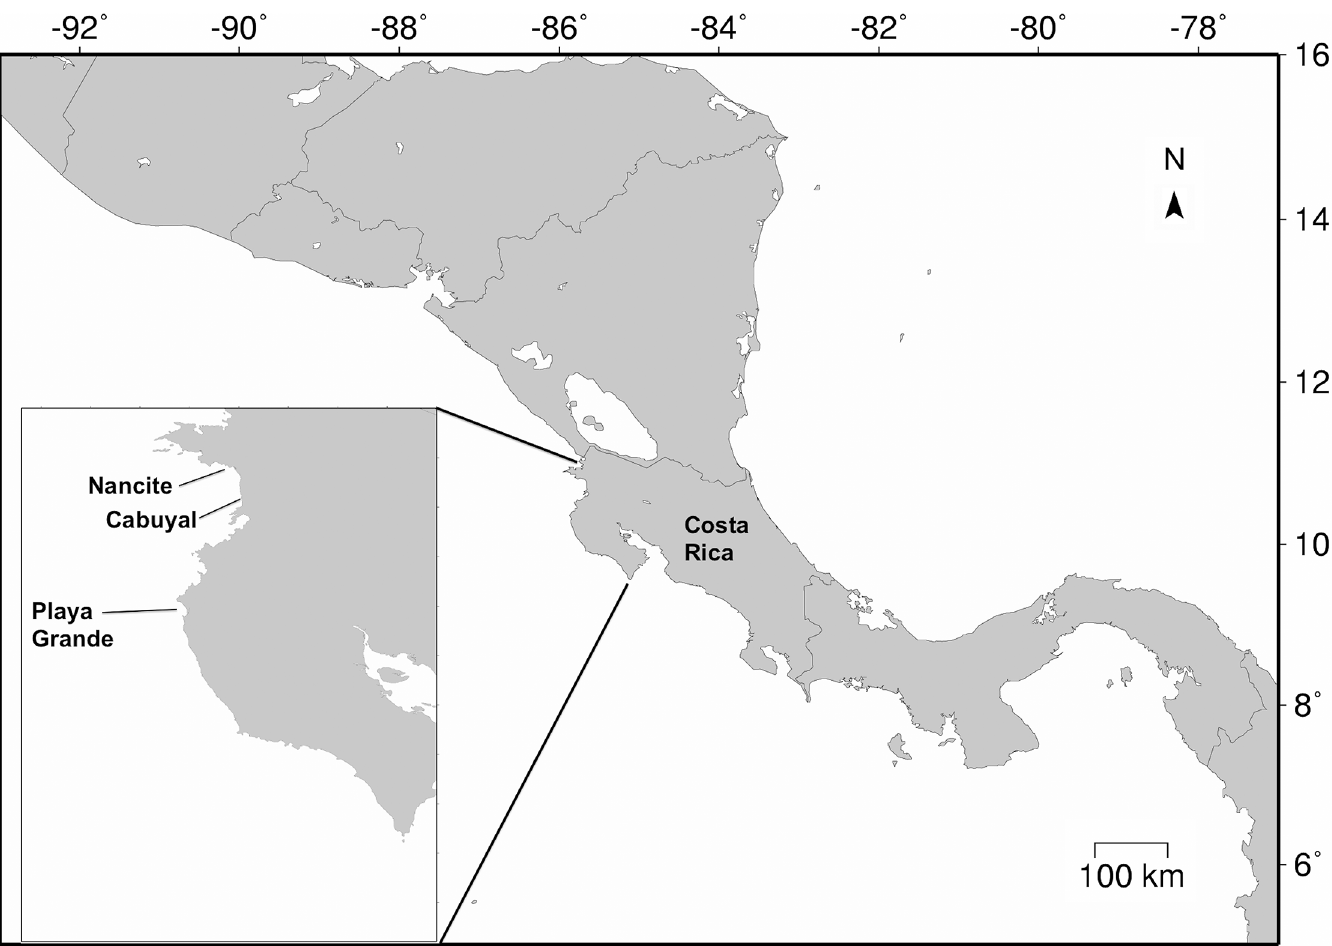
Fig 1. Location of study sites in Northwest Costa Rica. Nancite, Cabuyal and Playa Grande serve as nesting groundsfor olive ridley, green and leatherbackturtles respectively.